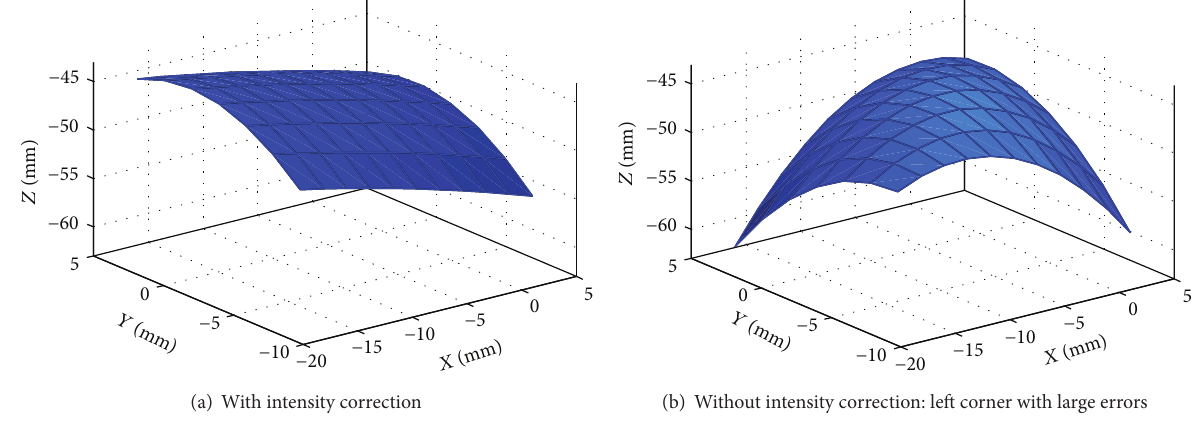
Figure 11: Reconstructed surface from stereo endoscopic images.